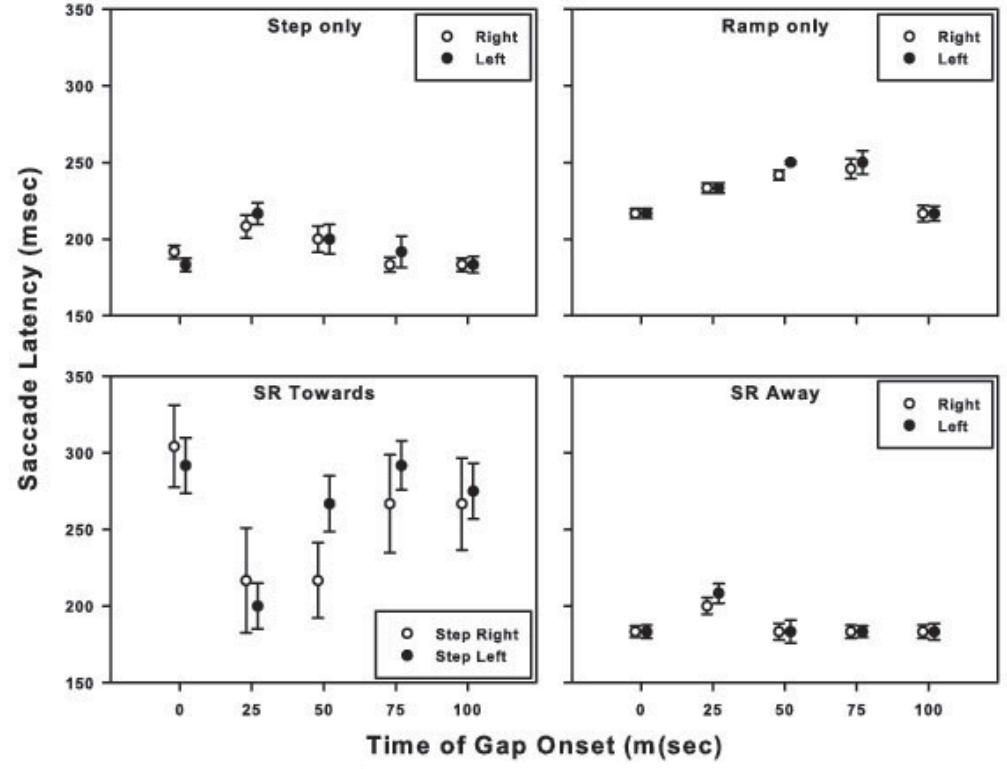
Figure 3 : The eye position relative to the target position is plotted against the saccade latency after the gap, for all sub- jects, with each panel representing a different stimulus